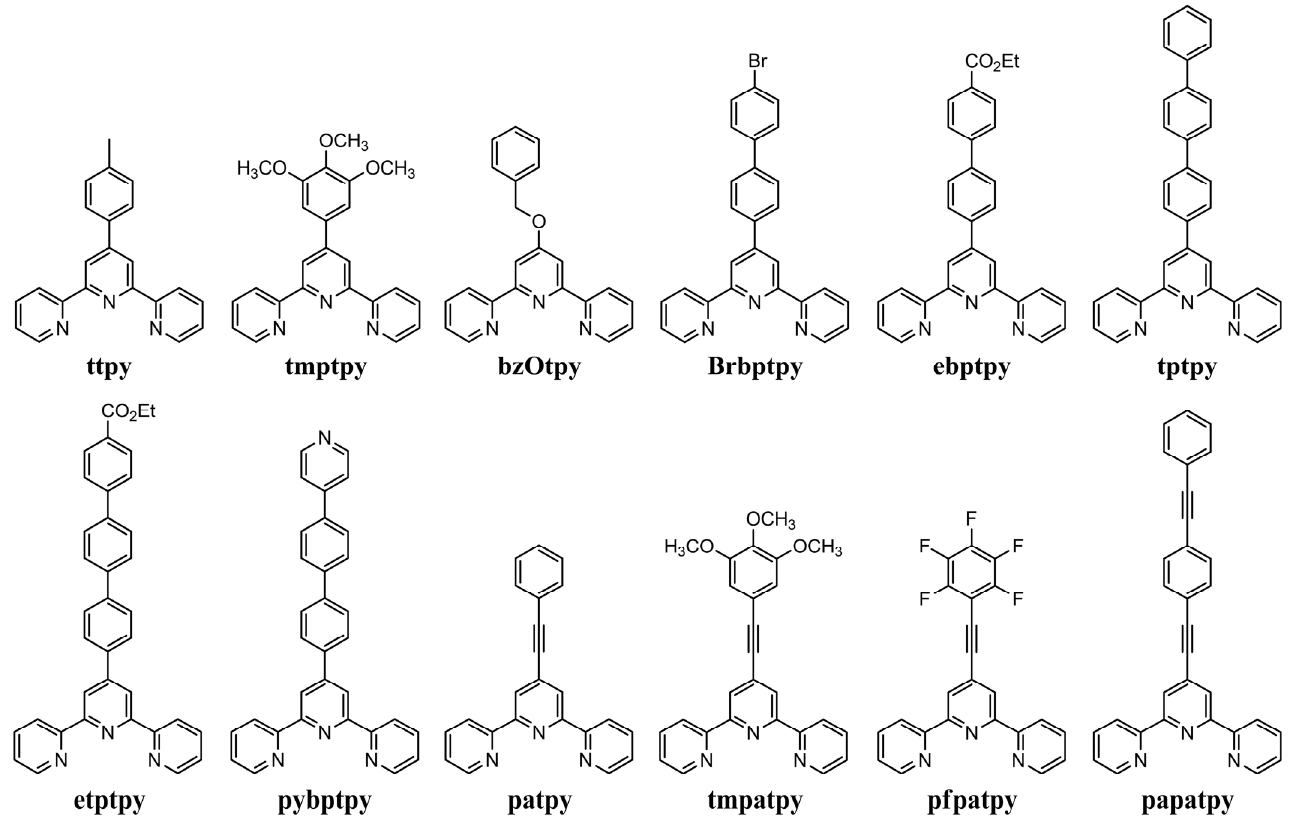
(cid:48) -substituted derivatives of 2,2 (cid:48) :6 (cid:48) ,2 (cid:48)(cid:48) -terpyridine studied in the present Figure 1. 4 ′ -substituted derivatives of 2,2 ′ :6 ′ ,2 ″ -terpyridine studied in the present work. Figure 1. 4